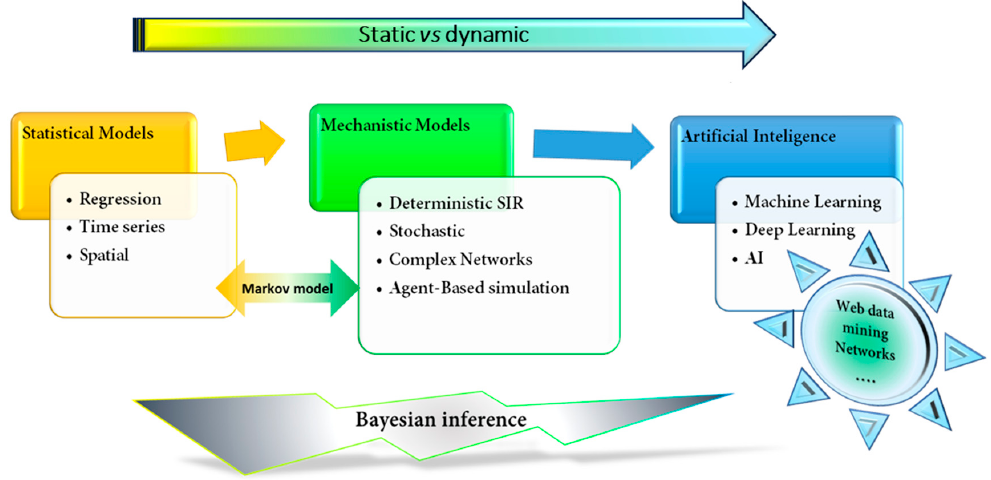
Figure 2. Schematic classification of mathematical models applied to epidemiology and medicine. The